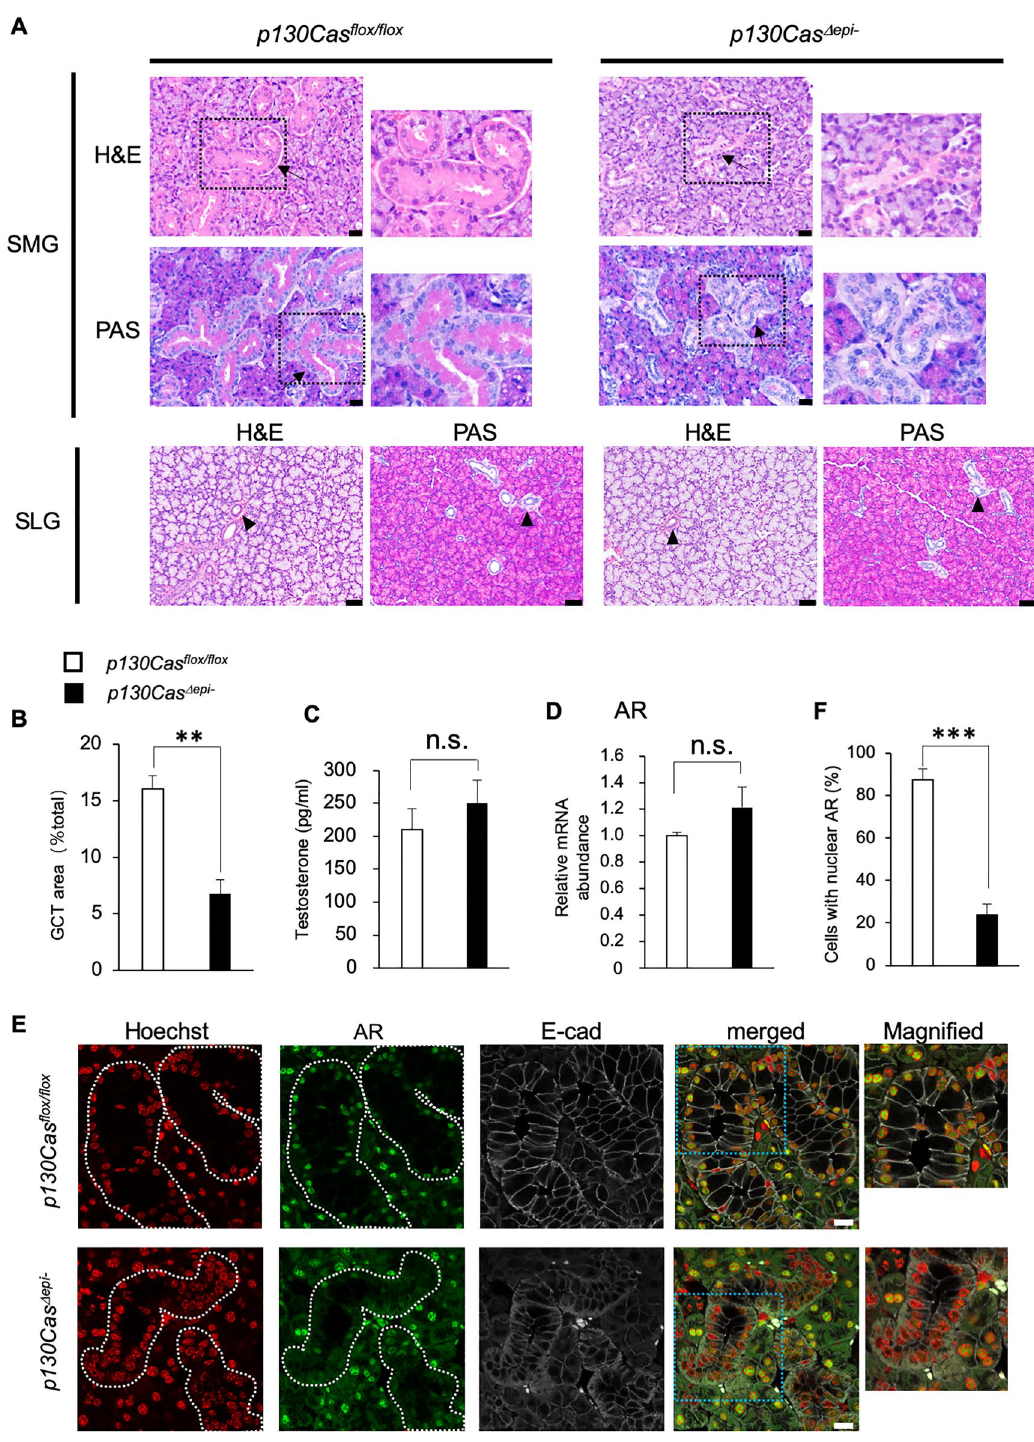
Figure 4. Immature development of the GCT of SMG in p130Cas Δepi– mice. ( A ) Histological analysis of SMG and SLG in P42 male p130Cas flox/flox and p130Cas Δepi – mice. Representative H&E and PAS staining images of paraffin sections. Arrows indicate the GCT in SMG. Arrowheads indicate ducts in SLG. Black boxed regions are shown as magnified images. Scale bars = 20 µm (SMG) and 50 µm (SLG). ( B ) Quantification of the ductal area per total gland area in P42 male p130Cas flox/flox and p130Cas Δepi– mice. ( C ) Serum testosterone levels in the P42 male p130Cas flox/flox and p130Cas Δepi– mice. ( D ) Quantitative real-time PCR analysis of relative mRNA abundance for the androgen receptor (AR) in SMG in the P42 male p130Cas flox/flox and p130Cas Δepi– mice. p130Cas flox/flox n = 10 mice, p130Cas Δepi- n = 7 mice. ( E ) Representative immunofluorescence staining of SMG paraffin sections using anti-AR (green) and anti-E-cadherin (gray). Nuclei were counterstained using Hoechst 33,342 (Red). Areas surrounded by white dotted lines indicate GCTs. Blue boxed regions are shown as magnified images. Scale bars = 10 µm. ( F ) The number of AR-positive nucleus of GCTs per field of view was quantified. Data show the means ± SEM, ** P < 0.01, *** P < 0.001 versus the corresponding p130Cas flox/flox